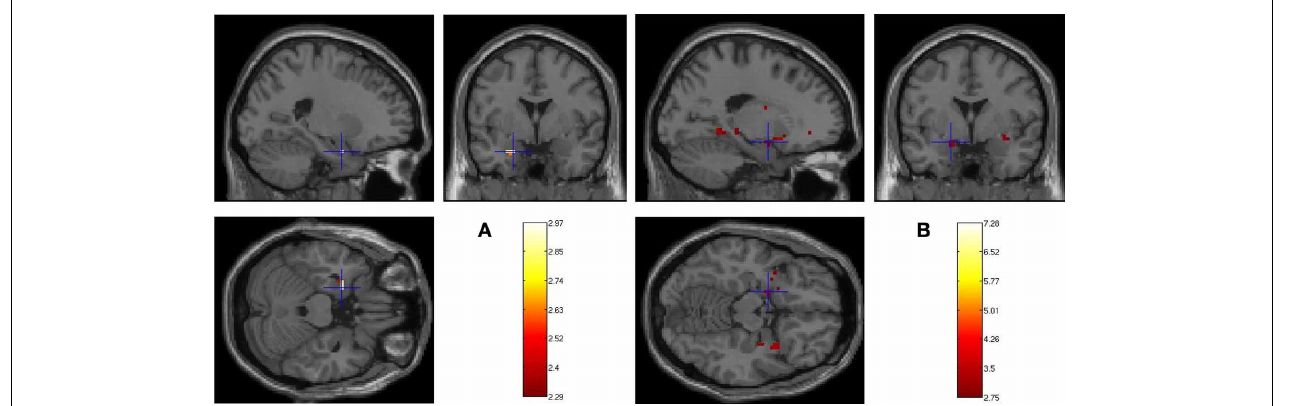
FIGURE 3 | Age-related changes in fearful faces successful encoding. Whole brain activations associated with Dm (Dm = Hits-Misses) centered on amygdaloid complex for (A) 13–17 > 8–12 years (left